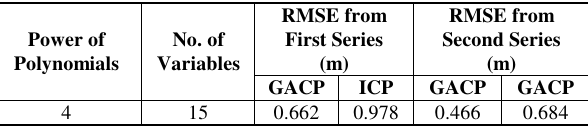
Table 6: Results Obtained from other Conventional